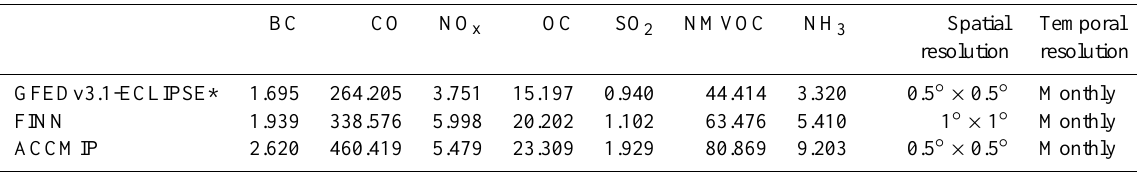
Table 2. Total annual amounts of pollutants emitted by wildfires according to the different inventories used, for 2008 (in Tga − 1 ). NO x is reported as NO. (*)GFEDv3.1 without the AWB is here called GFEDv3.1-ECLIPSE